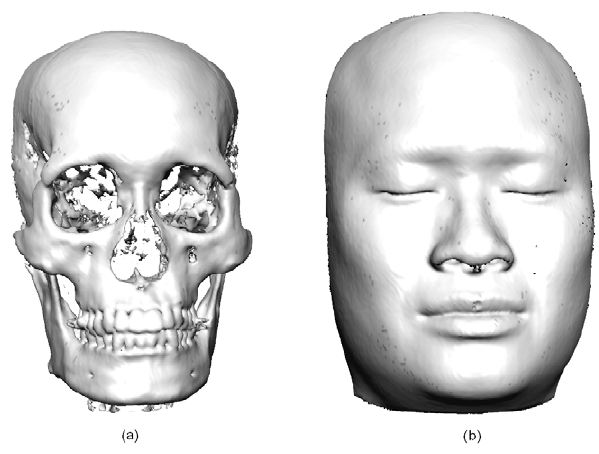
Figure 1. 3-D hard and soft tissue images generated by Cone- beam CT.